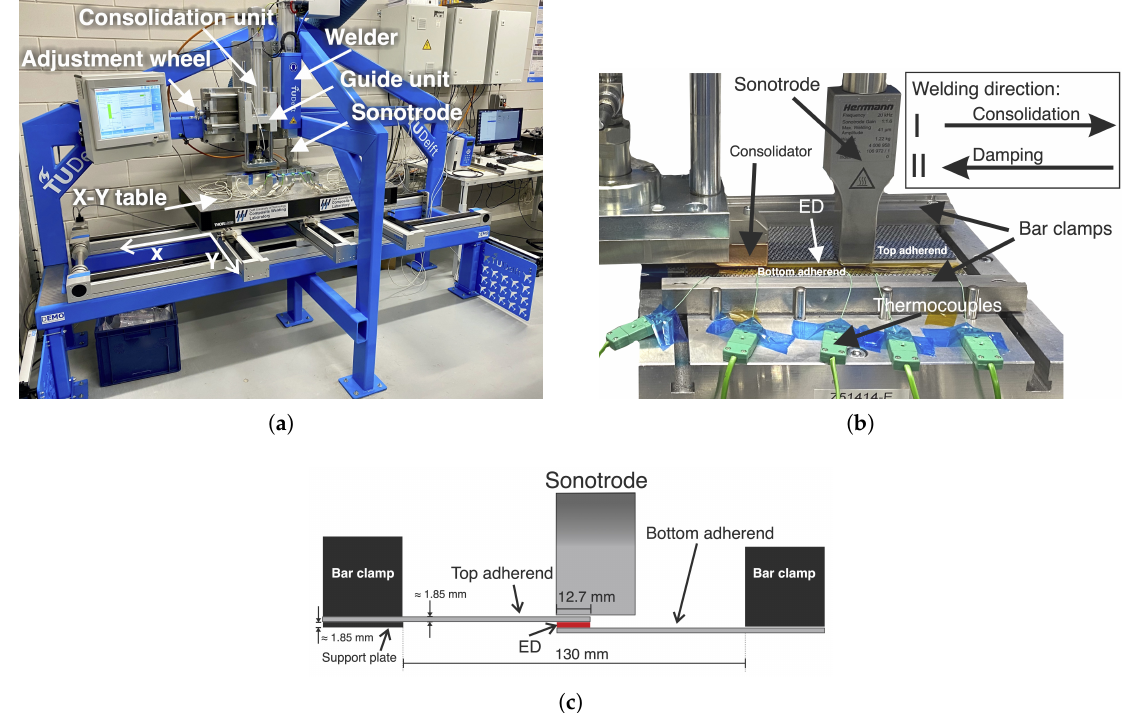
Figure 3. ( a ) Custom-built welding machine for static and continuous ultrasonic welding, ( b ) close-up of the continuous welding set-up visualising relative sonotrode and consolidator placement, and ( c ) schematic side-view of clamping distance and sonotrode